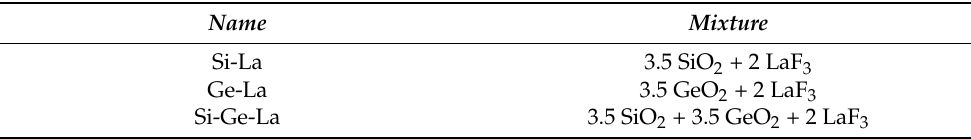
Table 5. Nomenclature of different studied